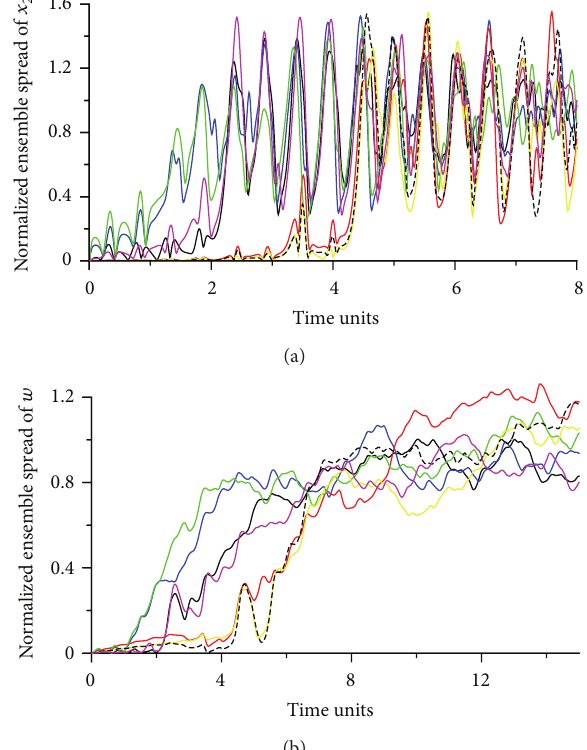
Figure 2: Time series of sensitivities of (a) 𝑥 2 and (b) 𝑤 with respect to 𝜎 (pink), 𝜅 (green), 𝑏 (black), 𝑂 𝑚 (dashed-black), 𝑂 𝑑 (yellow), 𝑐 1 (blue), and 𝑐 2 (red). Note that here the sensitivities of 𝑤 are computed as the ensemble spreads normalized by their 𝑥 2 and climatological standard deviations (i.e., 14.5 and 1.5). Parameters 𝜎 , 𝑐 𝜅 , 𝑏 , 𝑂 𝑚 , and 2 are dimensionless while the units of 1/Δ𝑡 and ( ∘ C) −1 , where Δ𝑡 is the dimensionless time